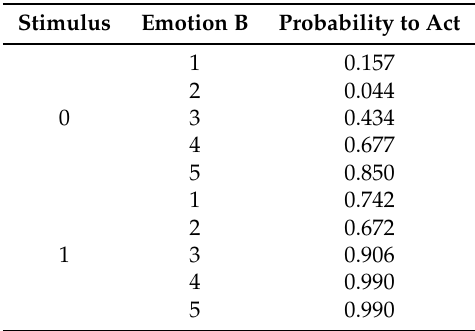
Table 3. Probabilities to Action according to Stimulus and